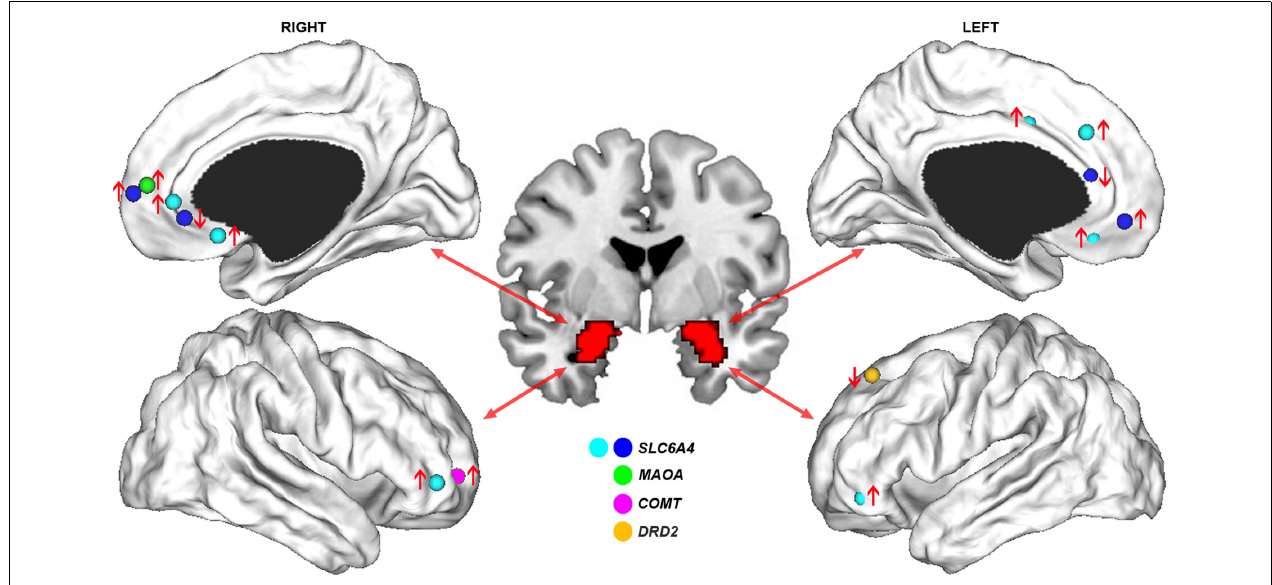
decreased ( ↓ ) in carriers of the putative risk allele for each gene.The distinction between cyan and blue foci for SLC6A4 studies differentiates a single study examining functional connectivity during cognitive regulation of emotion (Schardt et al., 2010) from others involving passive perception of emotional stimuli.This distinction illustrates how the risk allele of 5-HTTPLR polymorphism of this gene can be associated with either increased or decreased functional connectivity with the amygdala in adjacent regions of right pre-genual ACC, depending on task